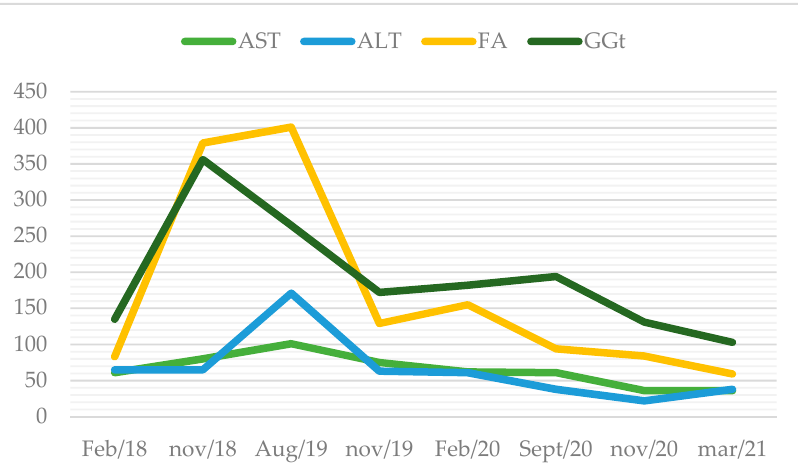
Figure 1. Evolution of liver enzymes over the years (in U/L).